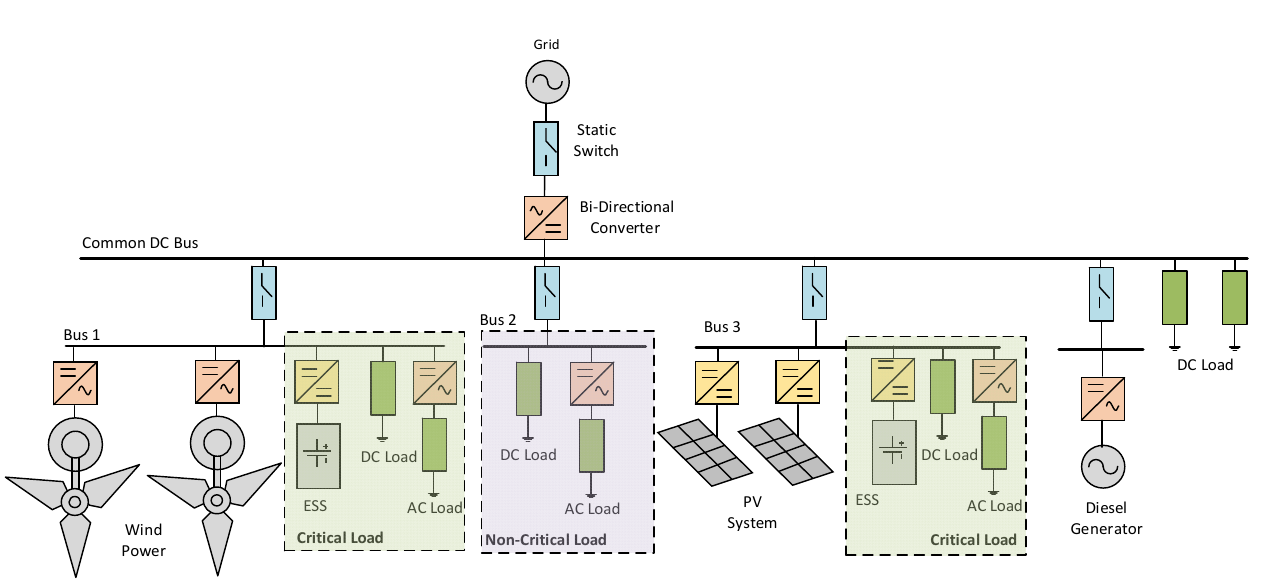
Figure 2. DC microgrid architecture.